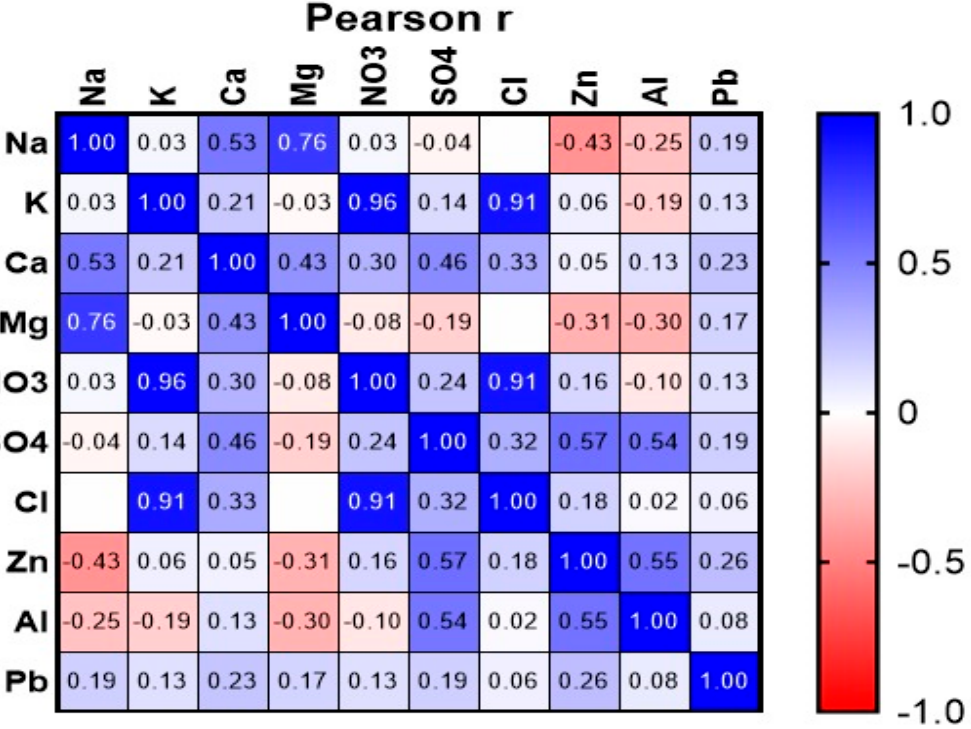
Figure 9. Pearson correlation matrix between ions and trace metals in fog water for present study.